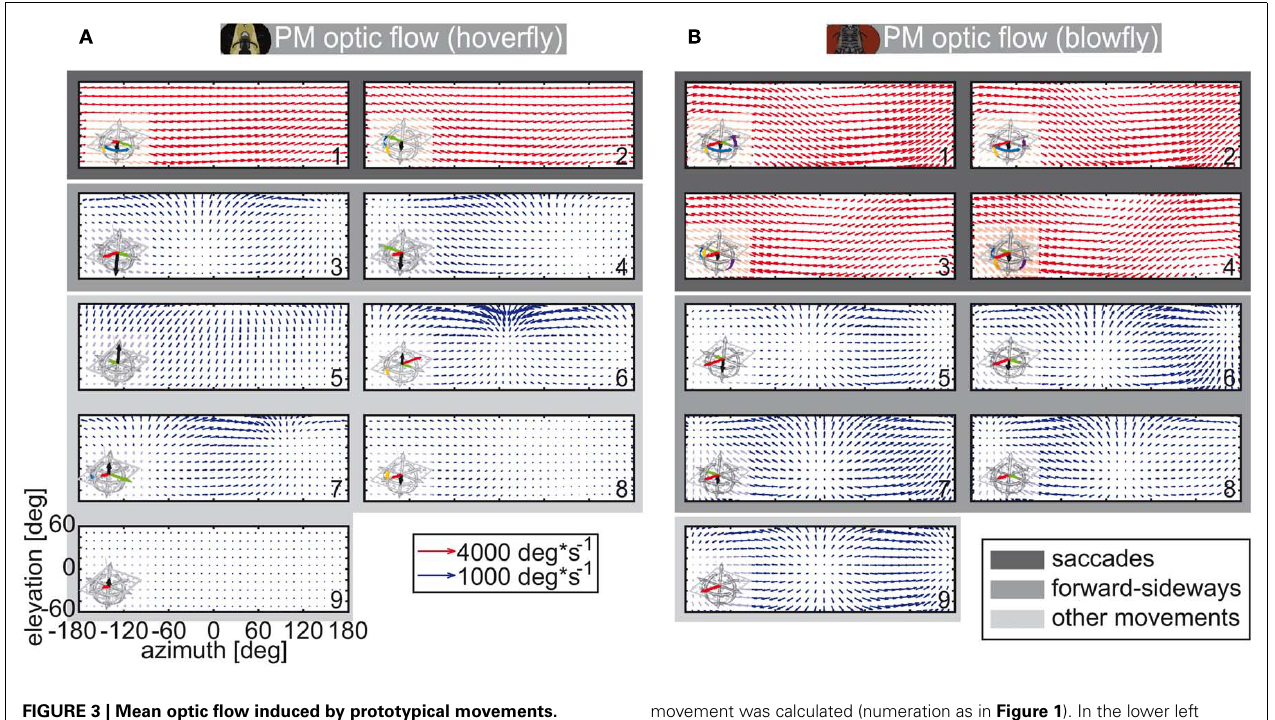
movement was calculated (numeration as in Figure 1 ). In the lower left corner of each flow field the corresponding PM is shown. (A) Eristalis optic flow calculated with head trajectories and segregated after body PMs. (B) Calliphora optic flow calculated from head trajectories and segregated after head